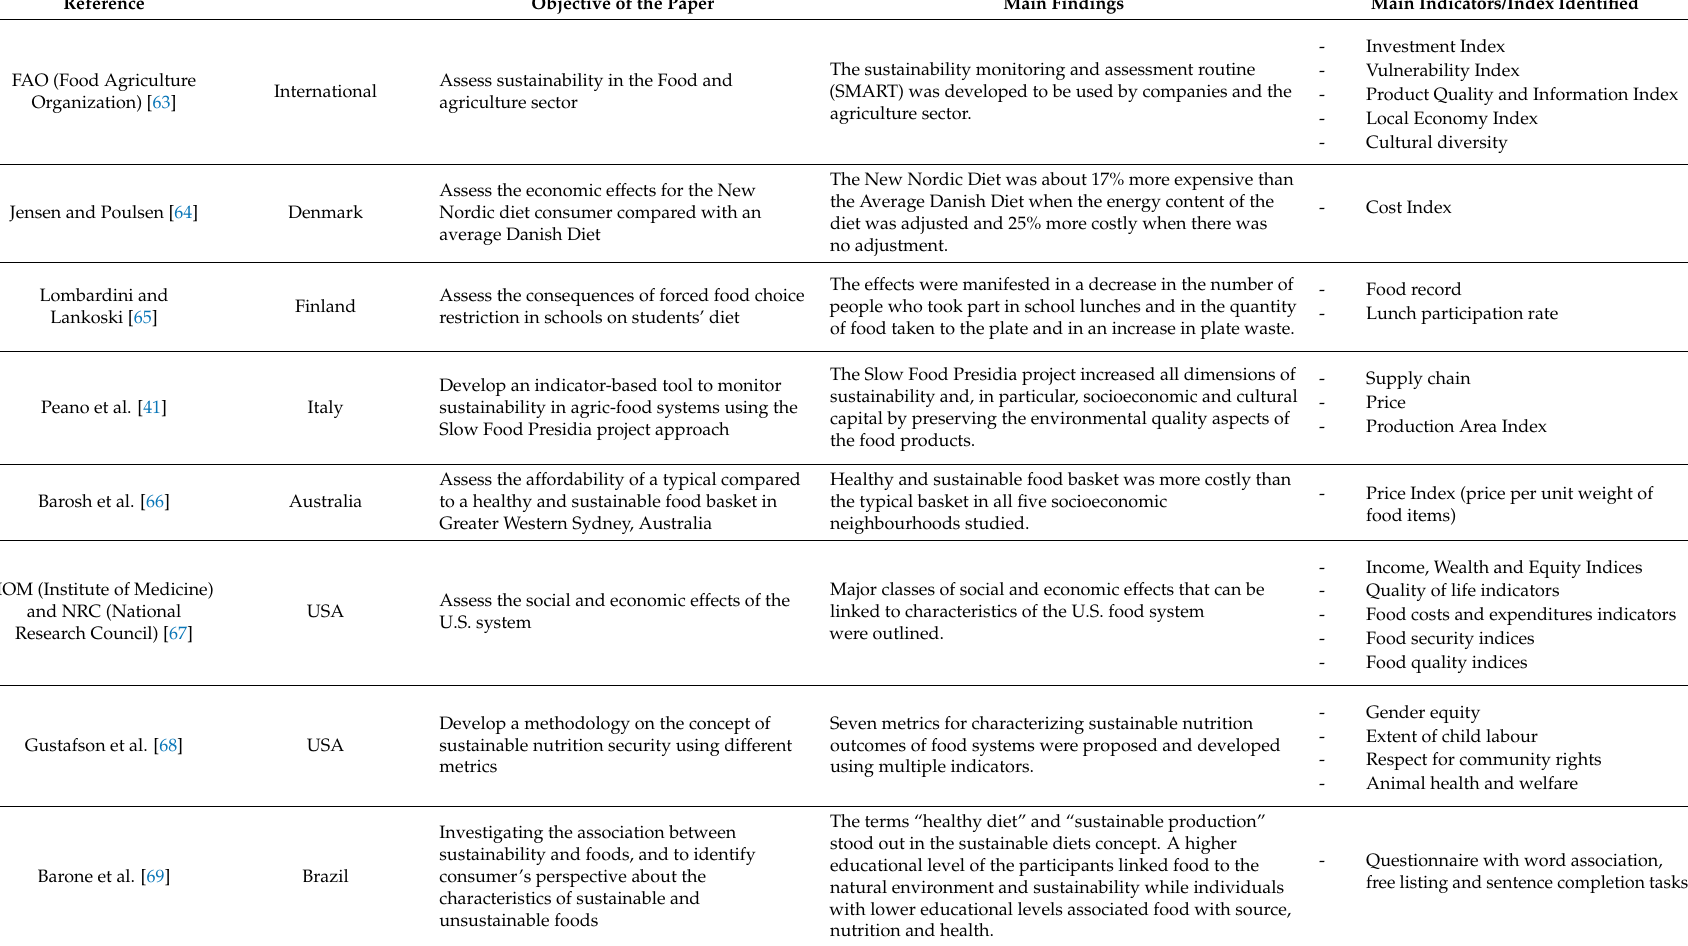
Table 3. The socioeconomic indicators used for assessing a sustainable